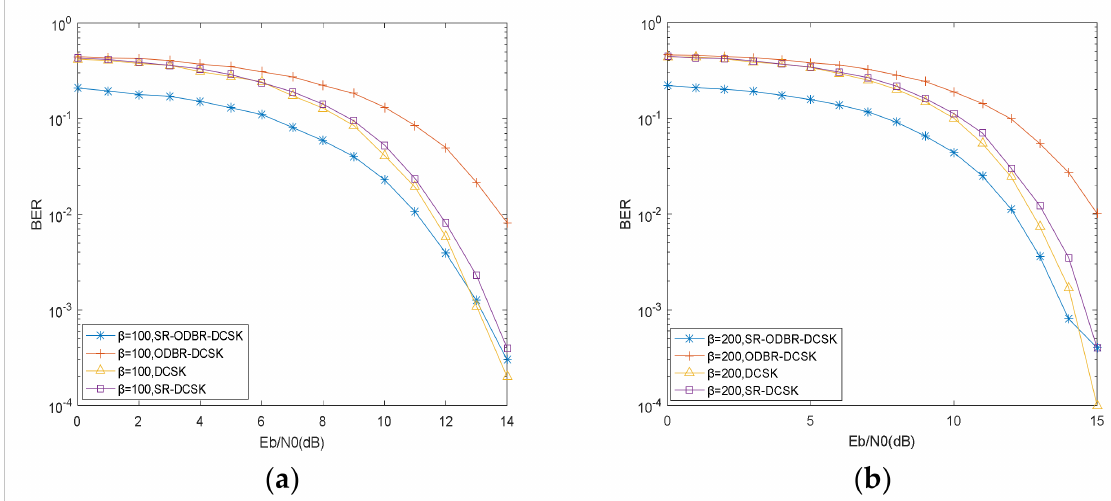
Figure 11. Comparison of the BER of four different systems. ( a ) β = 100; ( b ) β = 200.